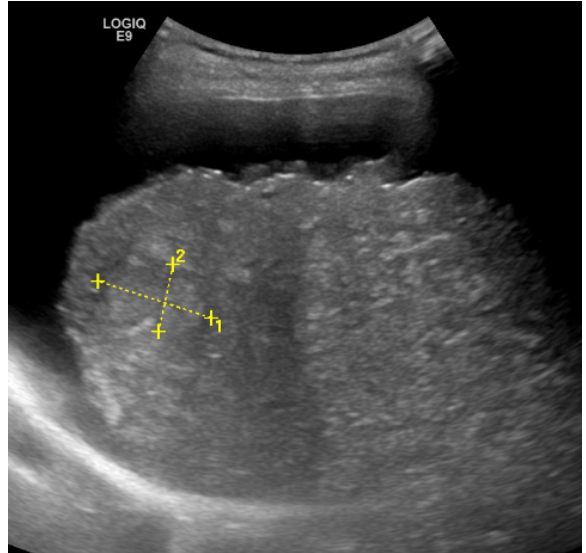
Figure 2. Characteristic changes in the liver. It shows nodular liver surface, perihepatic ascites, and inhomogeneous parenchyma in a NAFLD patient. These findings are pathognomonic for cirrhosis. The lesion in the right lobe of the liver (dimension 1 and 2) is suspicious for HCC.